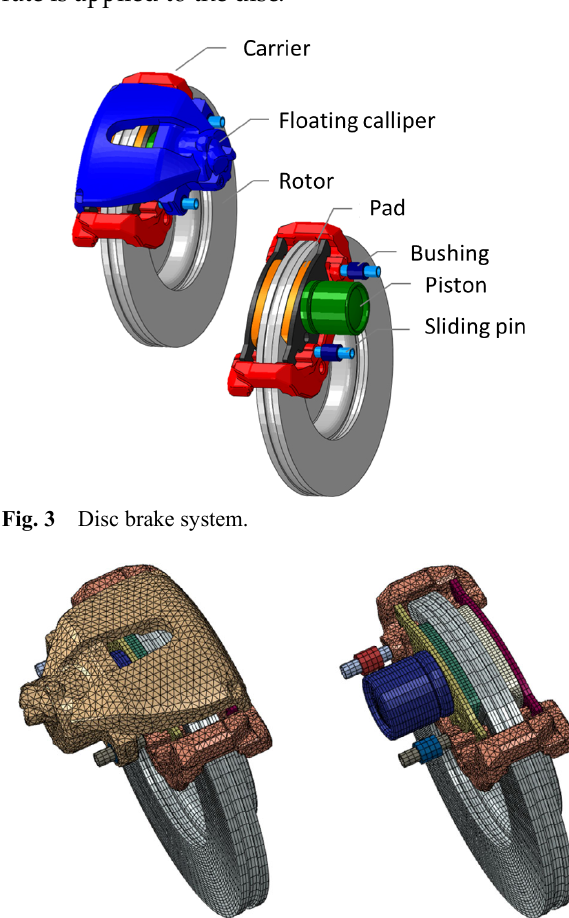
Fig. 4 Brake system